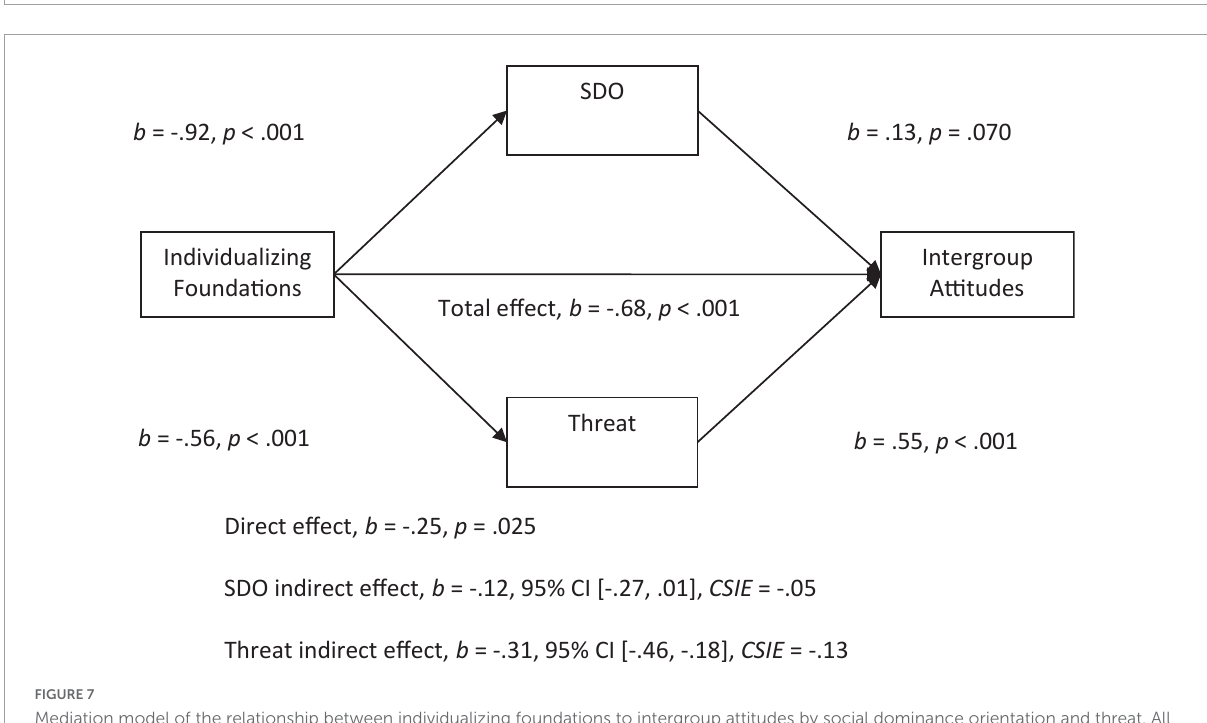
FIGURE7 Mediation model of the relationship between individualizing foundations to intergroup attitudes by social dominance orientation and threat. All betas represent unstandardized values from the Bootstrap analysis with 5,000 samples. CSIE represents the completely standardized indirect